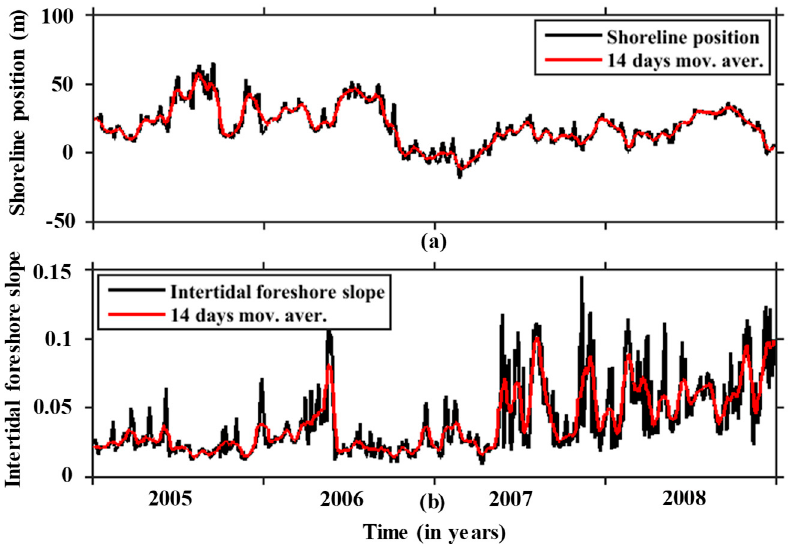
Figure 5. The temporal variations of ( a ) the shoreline positions and ( b ) the intertidal foreshore slopes at the research pier. The red line indicates the 14-day moving average shoreline positions and slopes.